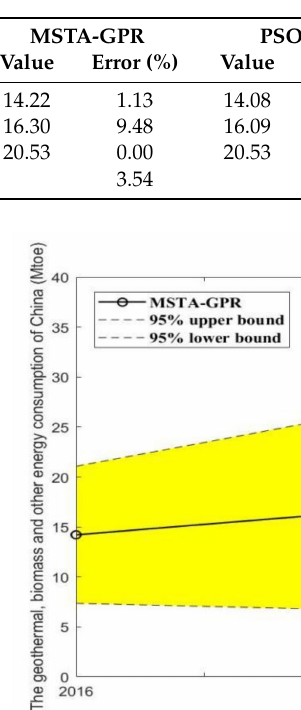
Table A4. Consumption prediction for geothermal, biomass and other energy from 2016 to 2018 (Mtoe).